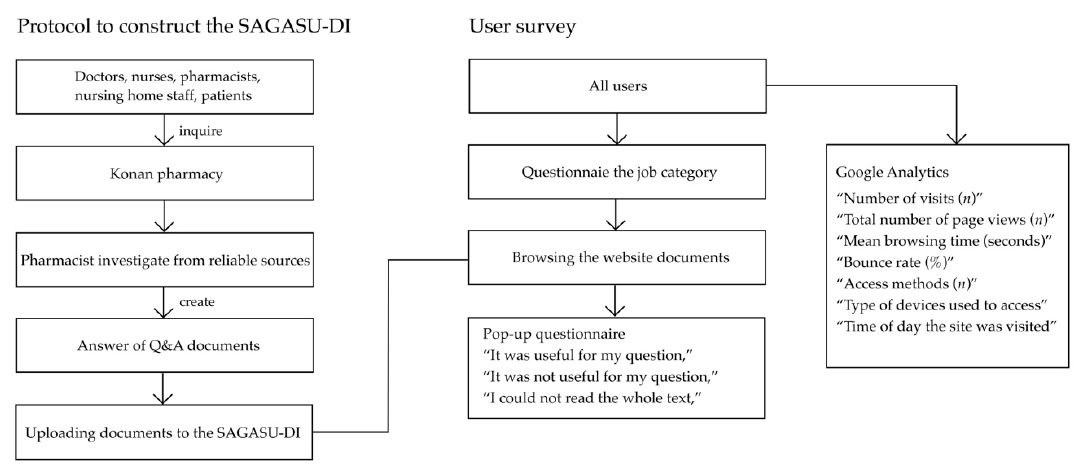
Figure 1. Protocol to construct the SAGASU-DI and flowchart of user survey.